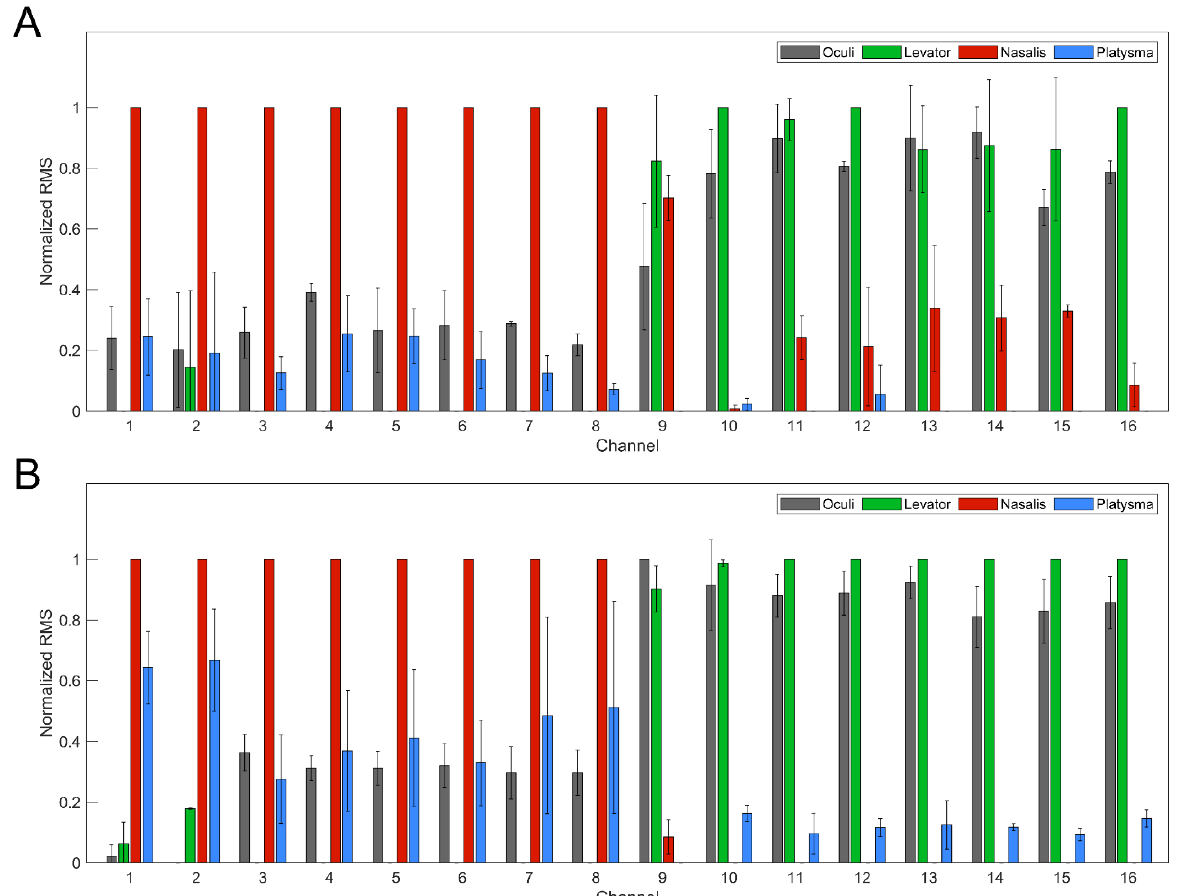
Figure 3. Average normalized RMS from EMG recordings of oculi, levator, nasalis, and platysma for all 16 channels at a current intensity of 15 µ A at ( A ) the beginning of stimulation experiments (i.e., 6 months post-implantation) and ( B ) the end of the study. Stimulation of channels 1–8 resulted in activation of nasalis and platysma, while stimulation of channels 9–16 produced selective activation of oculi and levator. Error bars represent 1 standard deviation.